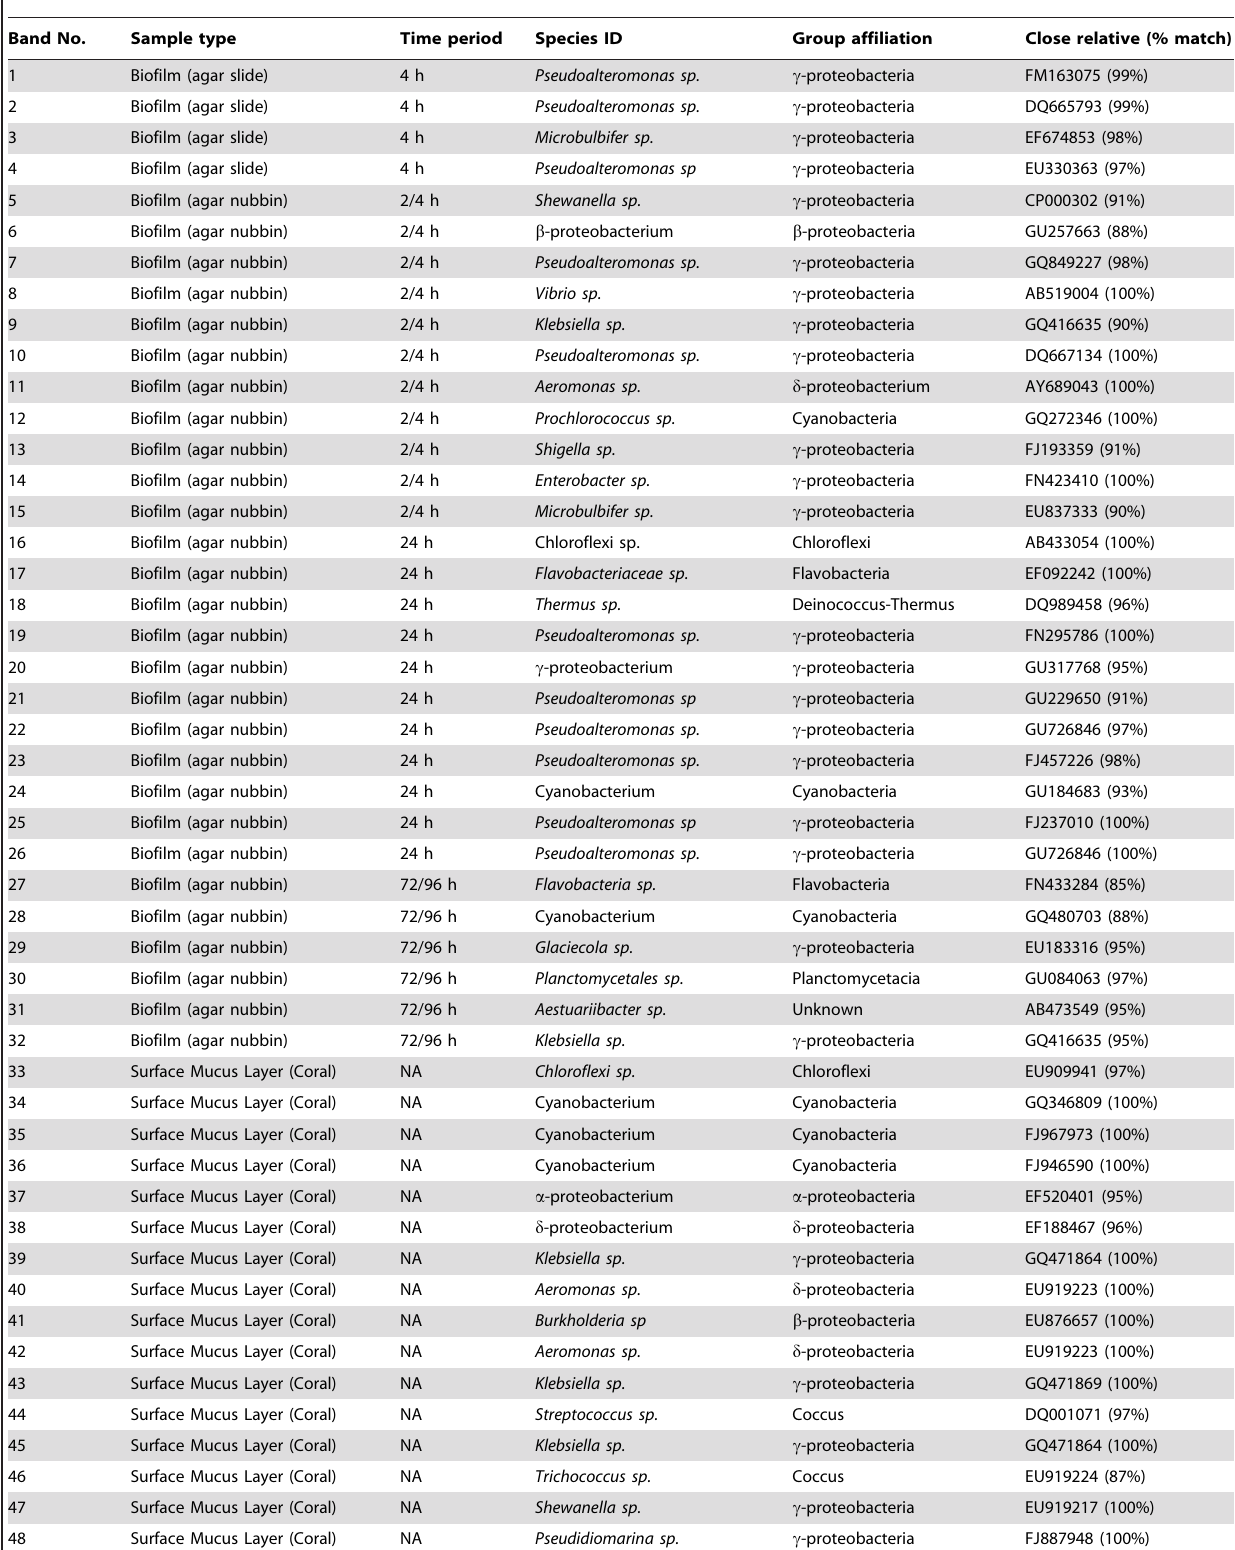
Table 2. Table showing the dominant 16S rRNA gene ribotypes, explaining the greatest differences/similarities between samples, excised from the DGGE